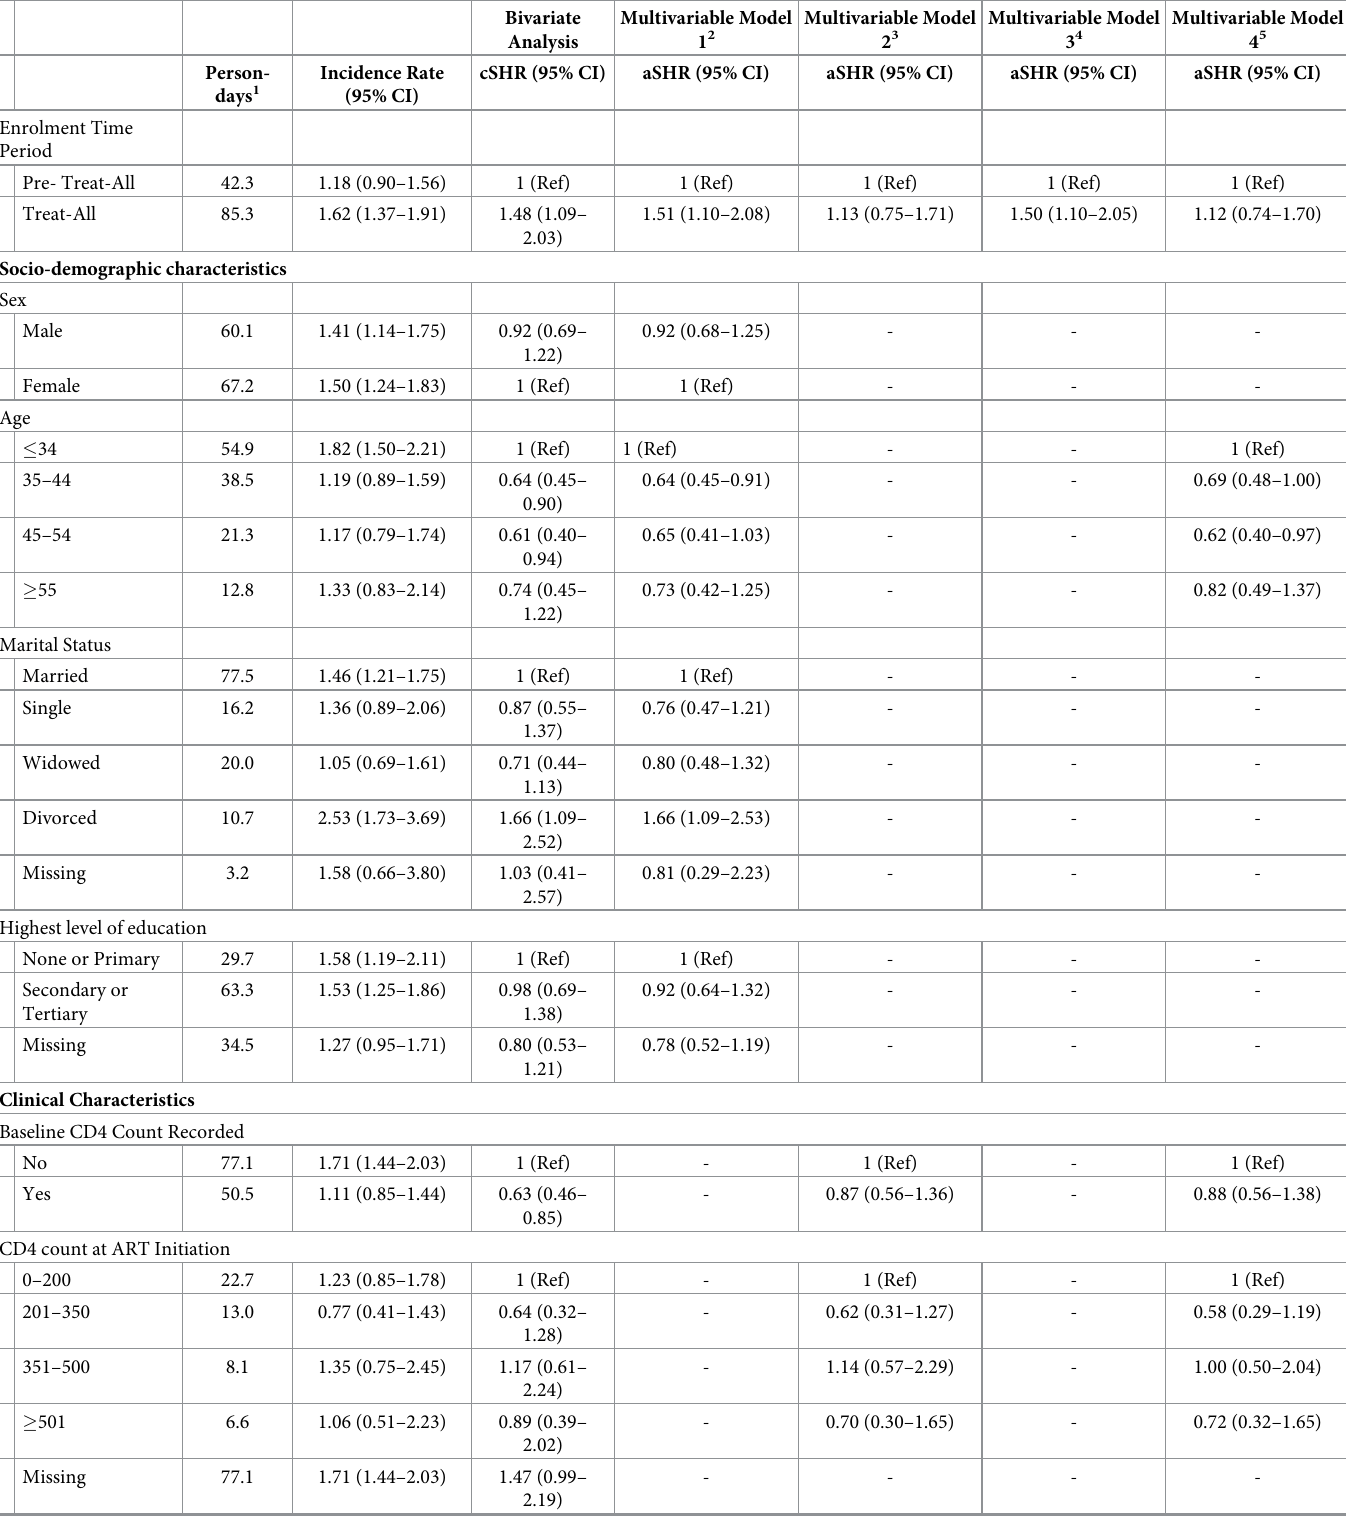
Table 3. Crude and adjusted measures of association between hypothesized predictors and attrition from